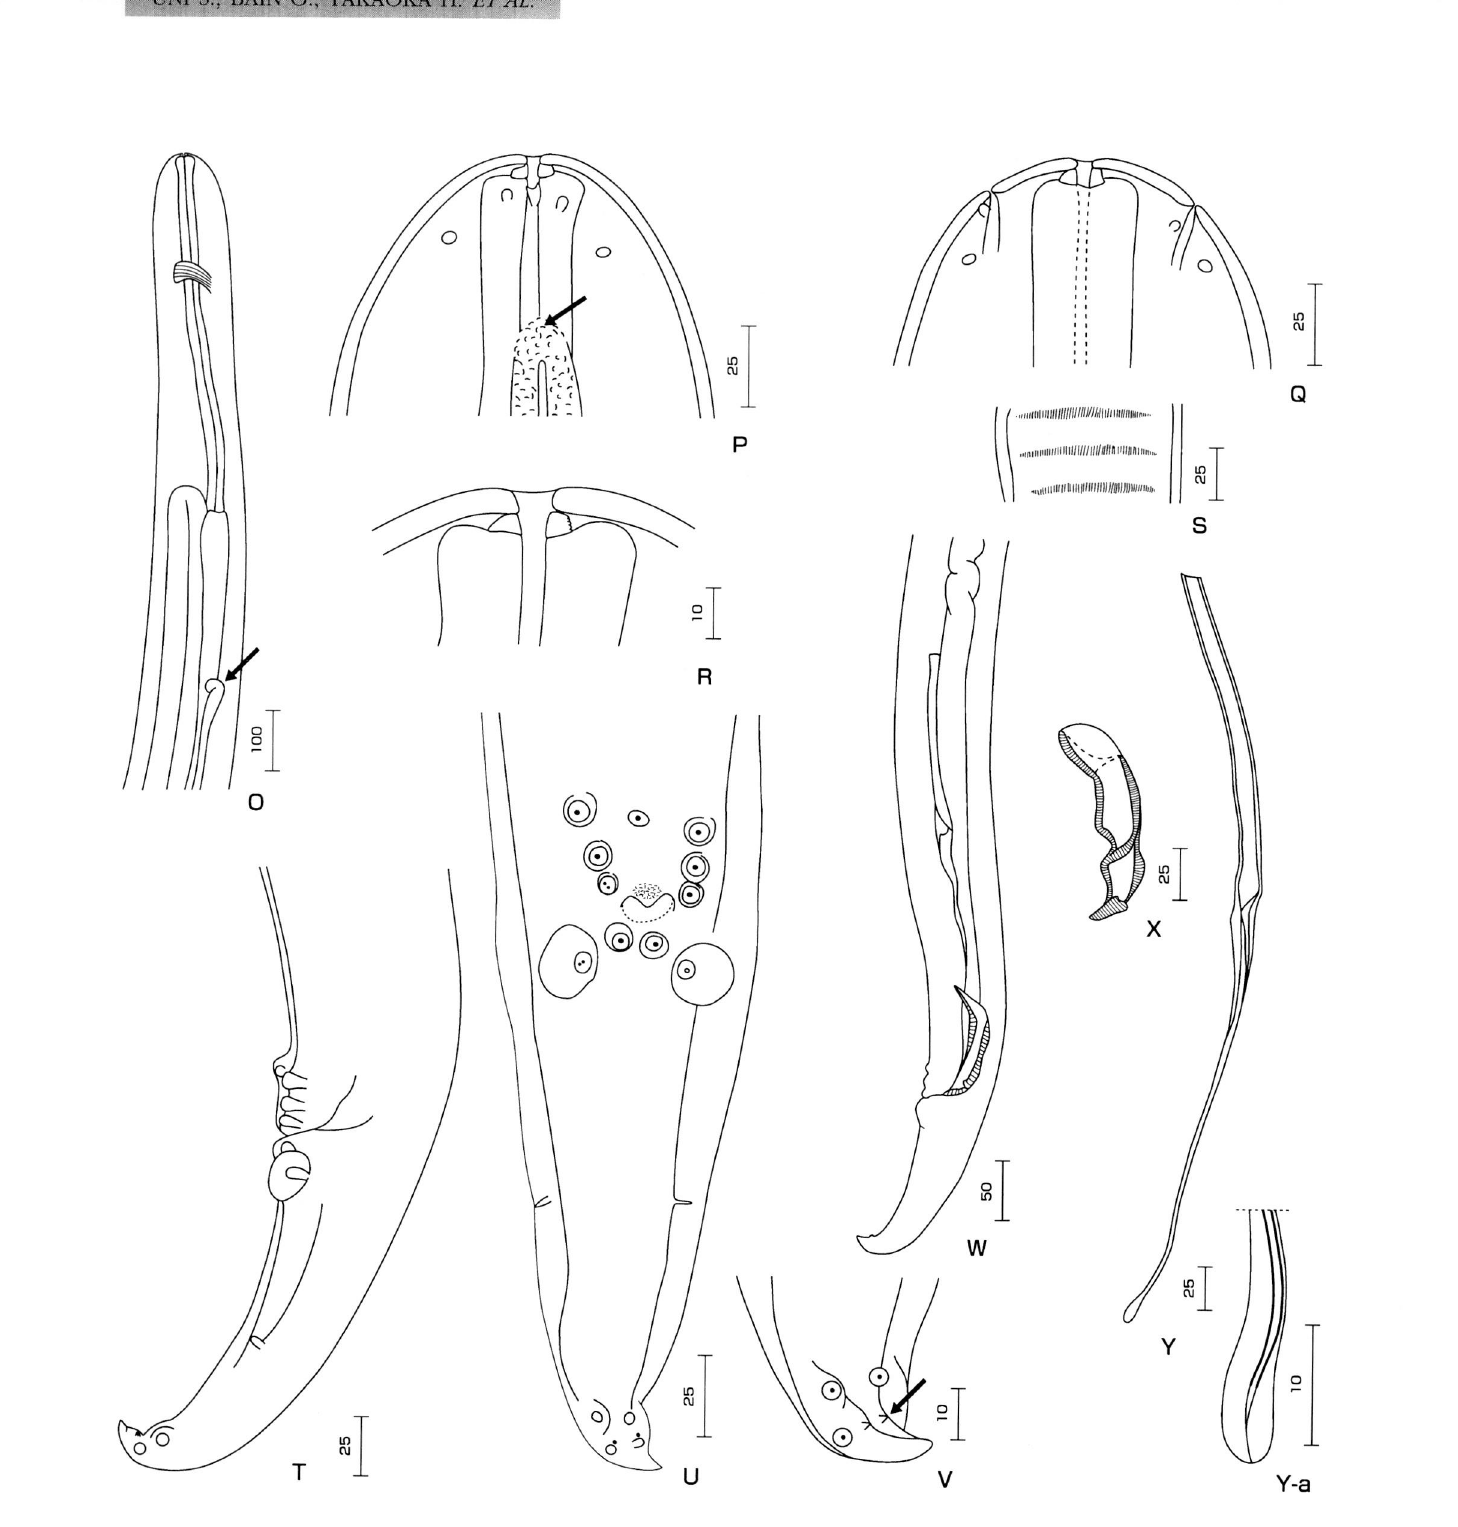
Fig. 4. - Cercopithifilaria crassa n. sp. O-Y-a, males. O. Anterior pan (arrow, apex of testis), lateral view. P. Head with beginning of lateral chord (arrow), lateral view. Q. Head, median view. R. Buccal capsule, median view. S. Area rugosa, ventral view T Tail lateral view. U. Tail, ventral view. V. Caudal extremity (arrow, phasmidial pore), subventral view. W. Posterior part, lateral view X Right spi­ cule, lateral view. Y. Left spicule, lateral view. Y-a. Left spicule, posterior end. Bars, micrometers.